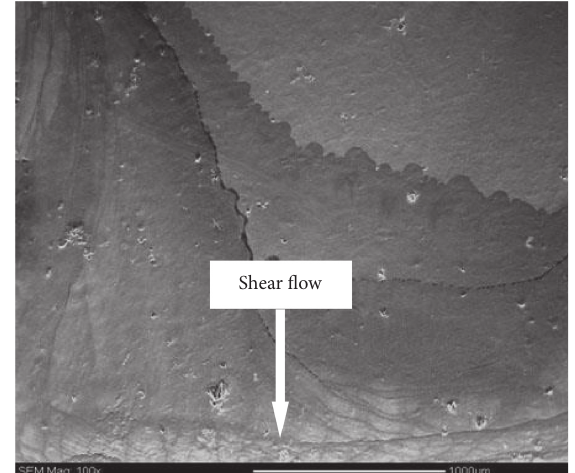
Figure 7: Obvious trace of shear flow of metals near nondissolved Fe-enriched precipitates